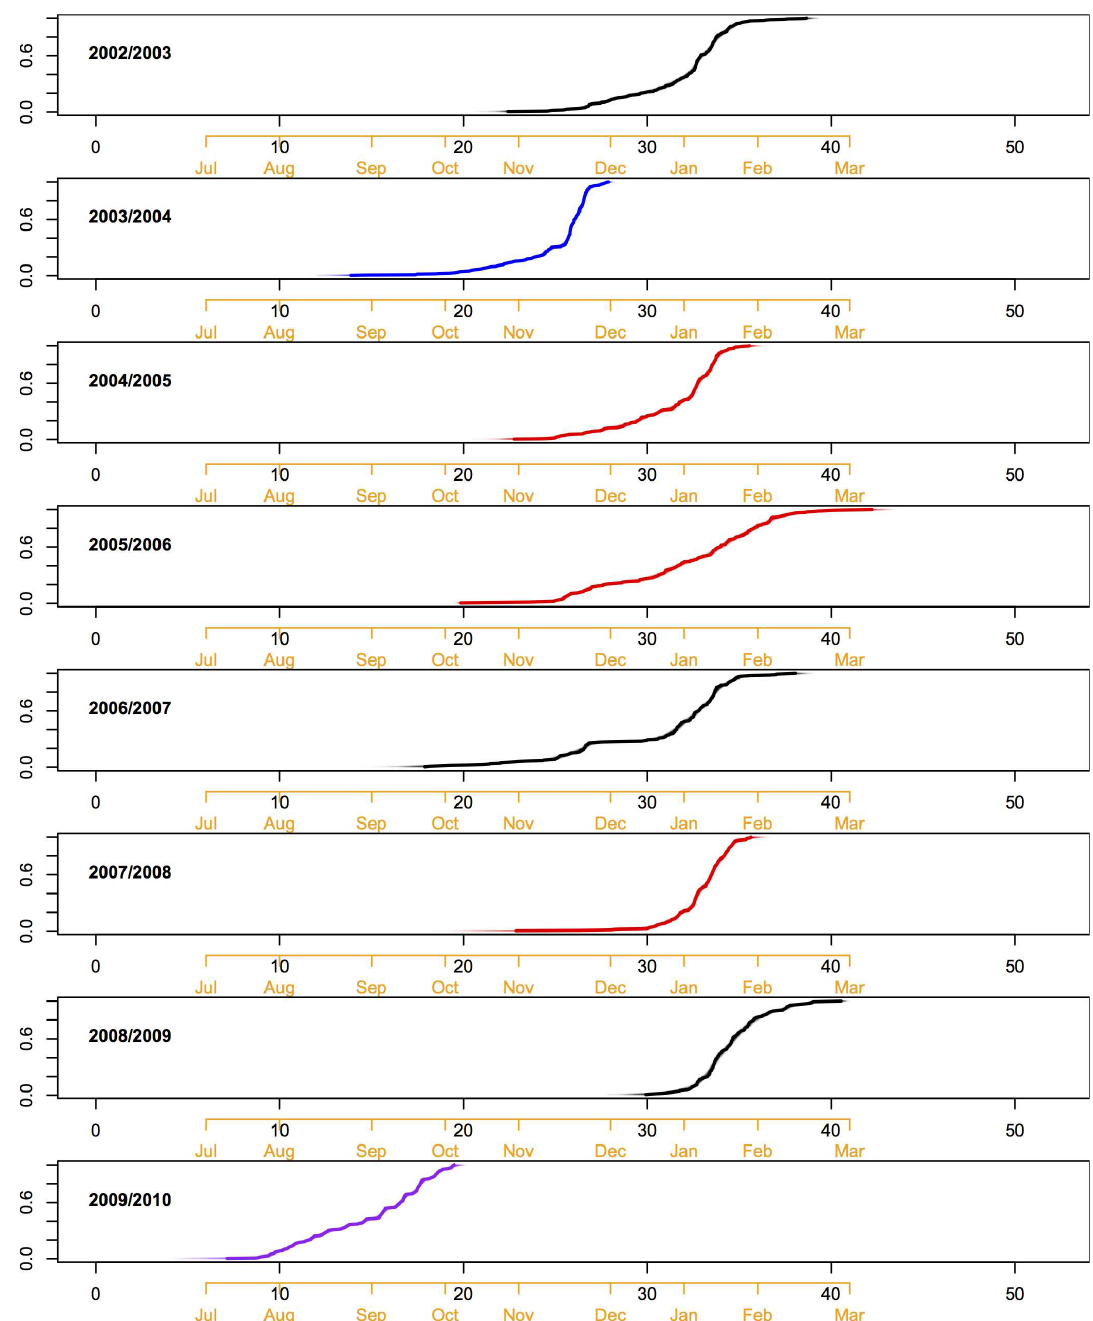
Fig 2. Cumulative epidemic curves display the proportion of locations infected over time in each season. In each panel, the x-axis represents weeks since June 1 st , with the corresponding calendar months labeled in orange. Each graph represents100 possibleepidemiccurves generated by varyinglocal onset times within estimated boundsof uncertainty. The tightness of the curves indicatesthat uncertaintyin local onset times has little effect on the epidemic’s overall trajectory. Epidemic curves are colored accordingto the dominant subtype in circulation(black correspondsto A/H1N1 + B, blue to A/ H3N2, red to A/H3N2 + B, and purple to A/H1N1pdm).